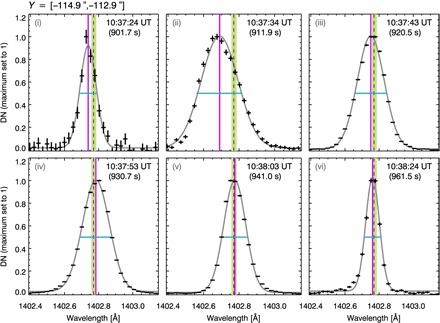
Temporal evolution of Si IV spectral lines during the flare.The Si IV lines at six example flare times (black), observed over a 2″ region along the north-south direction. The lines are fitted with a single Gaussian (gray) that provides an estimate of the line centroid position (vertical purple line) and FWHM (horizontal turquoise line). We show the inferred Si IV reference wavelength plus its uncertainty (1402.775 ± 0.020 Å) (lime regions) and the Si IV laboratory wavelength (1402.77 Å) (black dashed lines).